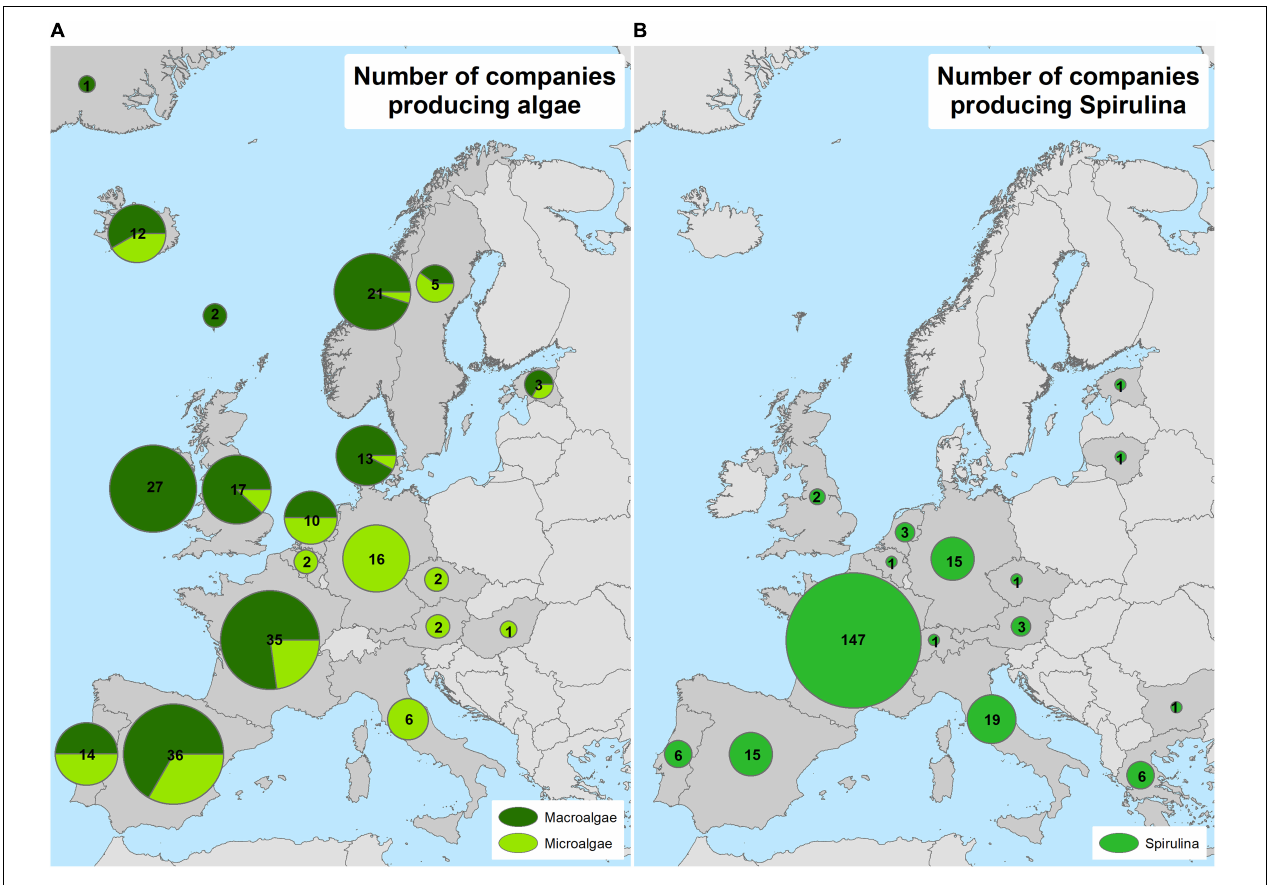
FIGURE 2 | Number and relative distribution between macro- and microalgae (A) and Spirulina (B) production companies by